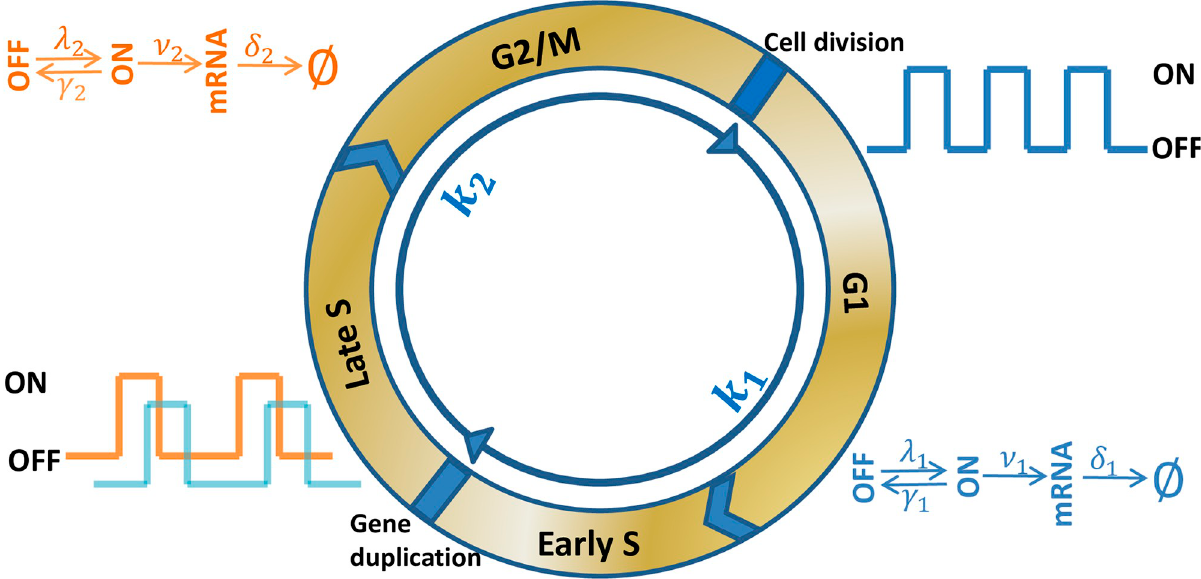
Fig 1. Coupling gene transcription with cell cycle. Actively dividing eukaryote cells go through G 1 , S , G 2 and M phases in one cell cycle. In our model, we divide one cycle into two stages: S (from last division to gene duplication) and S (from gene duplication to next division). Cells orderly rotate 1 2 between S and S stages with constant rates κ 1 and κ 2 . The promoter transits randomly between active and inactive states, and the transcription 1 2 kinetics changes with the cell cycle stages. During S stage, the kinetics is parameterized by activation rate λ 1 , inactivation rate γ 1 , synthesis rate ν 1 , and 1 mRNA degradation rate δ 1 . After DNA replication, the gene is duplicated into two identical copies that are transcribed independently with constant rates λ 2 , γ 2 , ν 2 and δ 2 in the same cell during S stage. 2